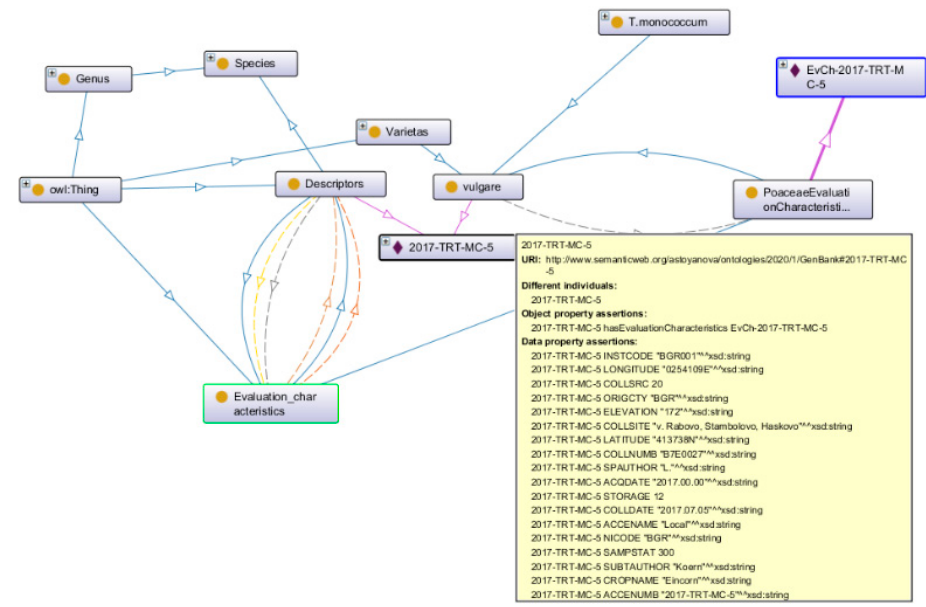
Figure 10. Descriptor and Evaluation_characteristics classes.